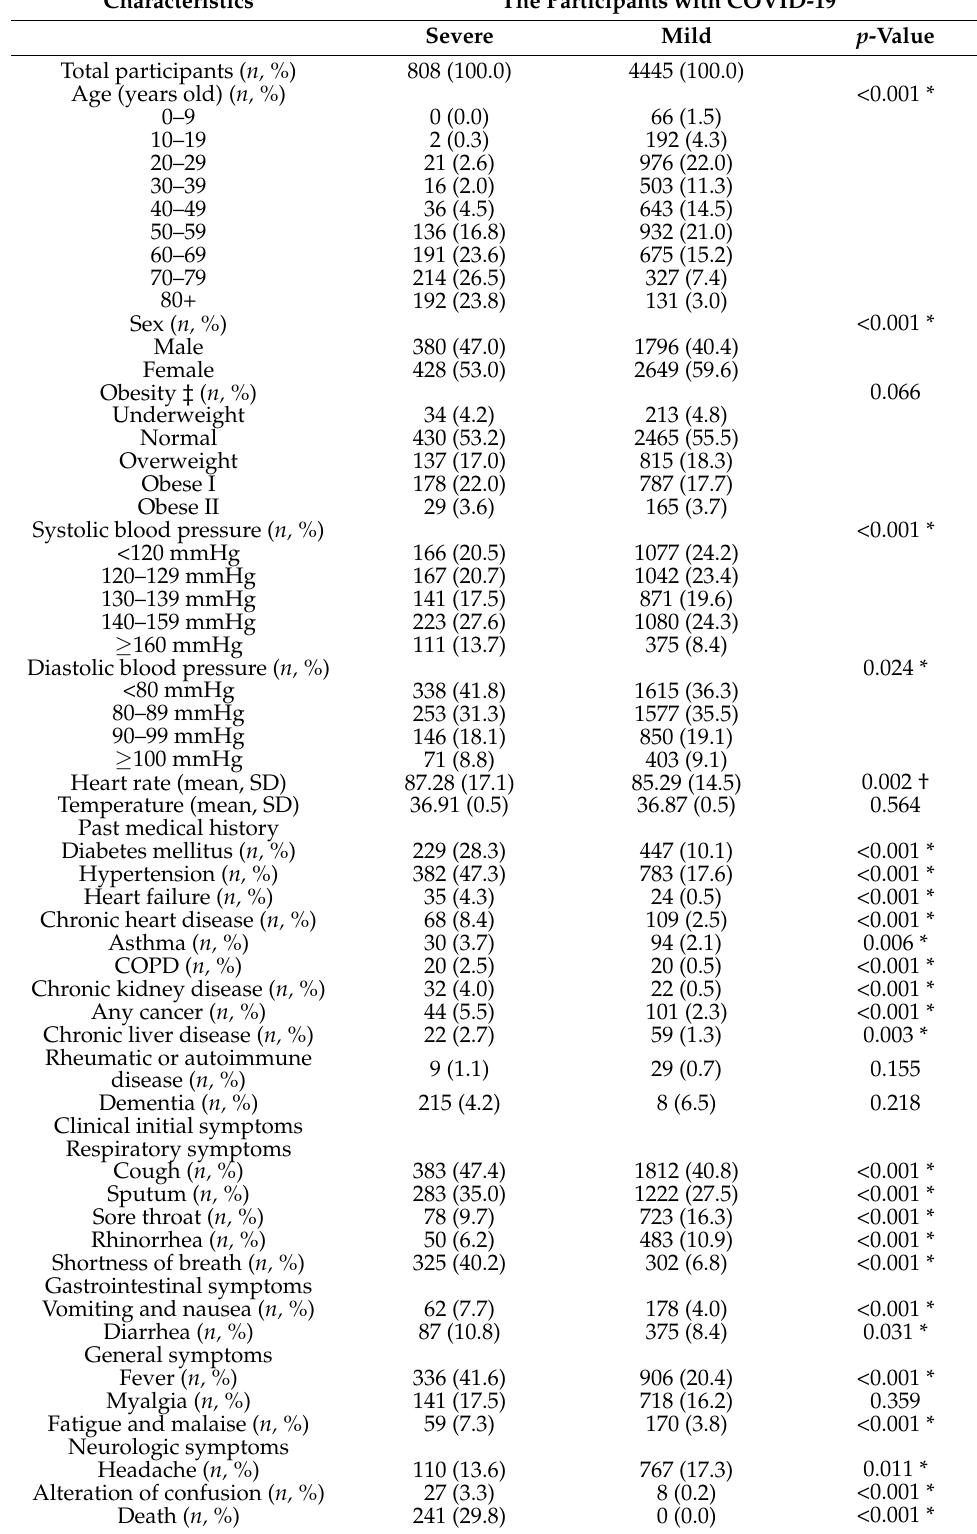
Table 1. General characteristics of the participants with COVID-19 according to severity of morbidity upon hospital